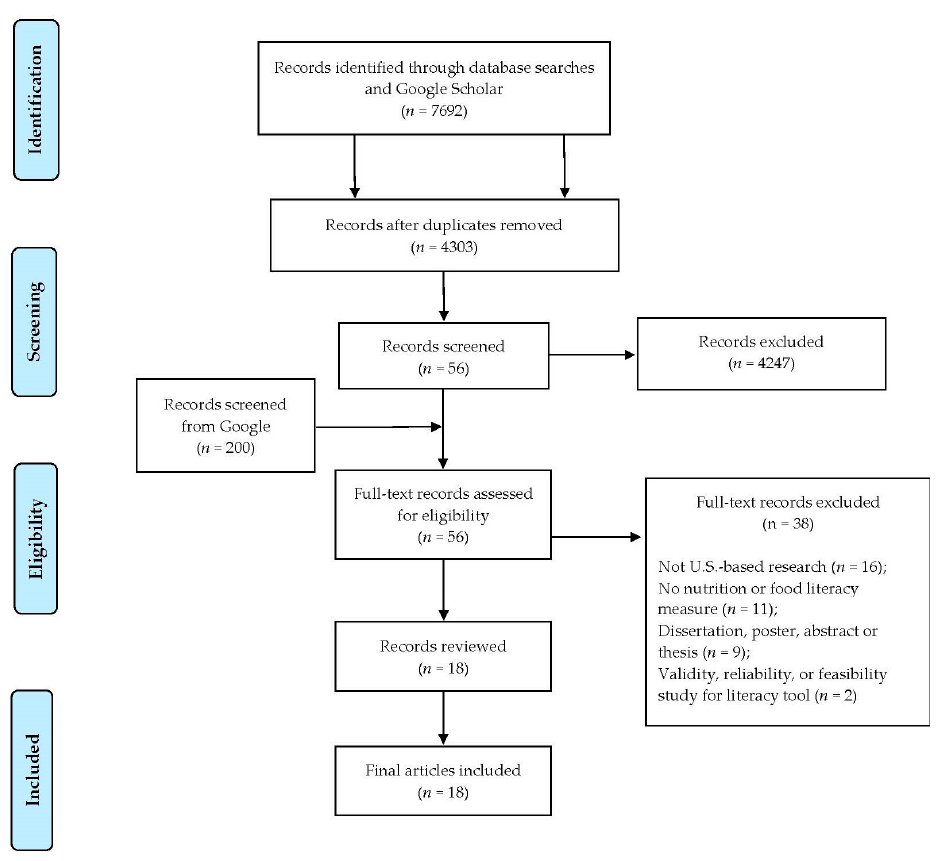
Figure 2. PRISMA flow diagram for the scoping review of studies that evaluated the food and/or nutrition literacy capacities and skills of U.S. adults.